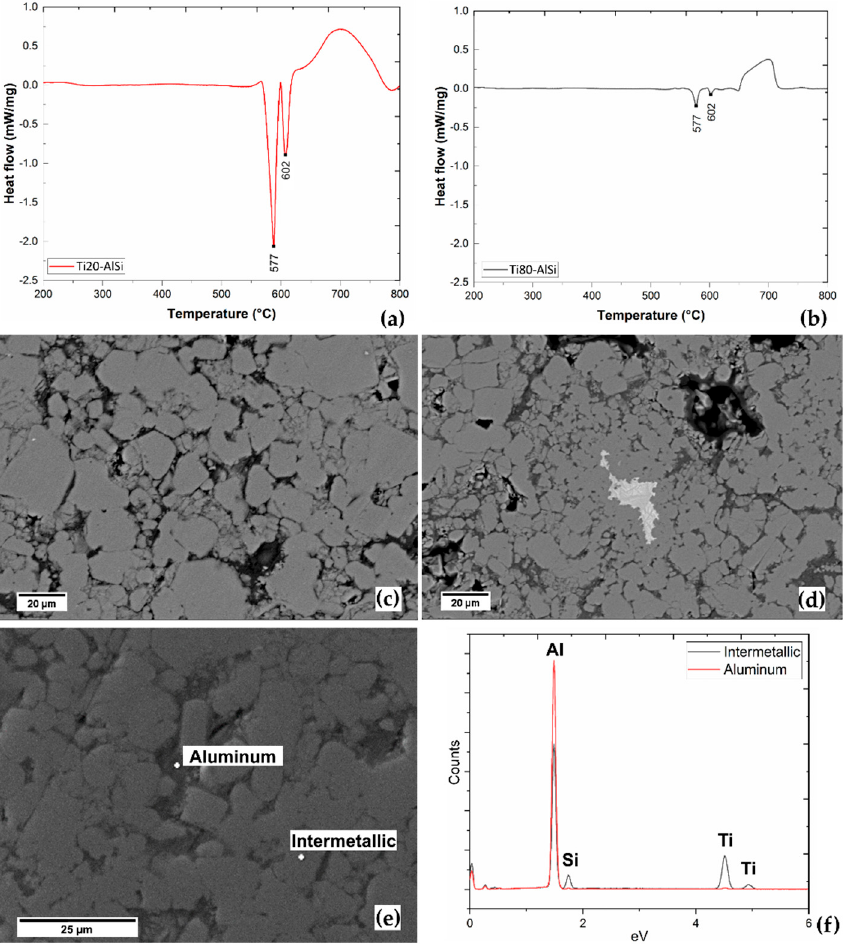
Figure 6. DSC and SEM/EDS analysis. ( a , b ) are the calorimetric analysis for Ti20-AlSi and Ti80-AlSi, respectively; ( c , d ) are BSE images of the microstructures after DSC; ( e ) region of interest (ROI) analysed by EDS; ( f ) EDS spectra of the ROI.